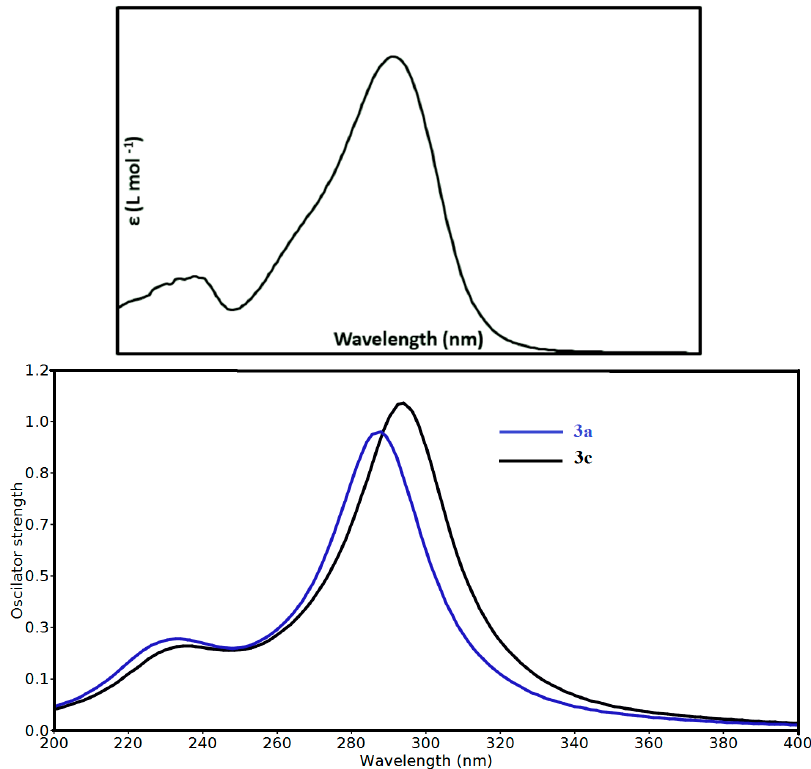
Figure 5. Experimental ( upper ) and calculated ( lower ) electronic spectra of the studied compounds using TD-DFT